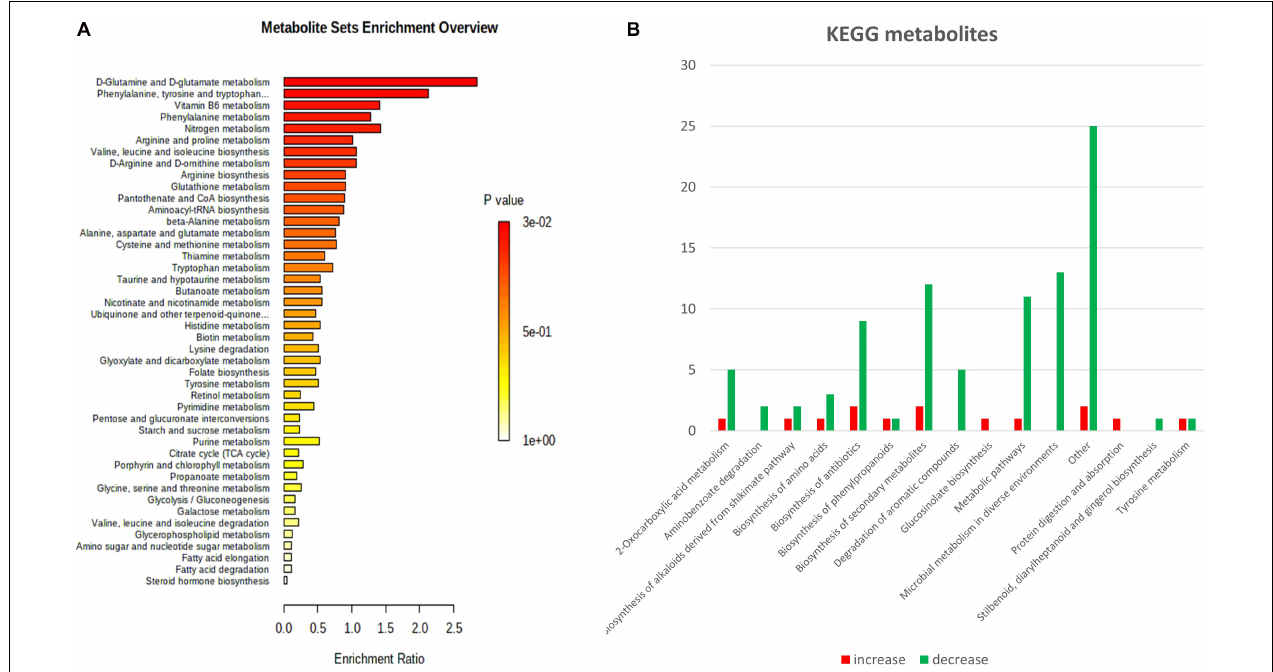
FIGURE 5 | Enriched pathways and differential metabolites and lipids in Arabidopsis leaves of wild type and dir1 mutant primed by Pst DC 3000 treatment. (A) MetaboAnalyst analysis of pathway enrichment for metabolites and lipids. (B) KEGG pathways of metabolites/lipids that are differentially abundant in wild type versus dir1 primed